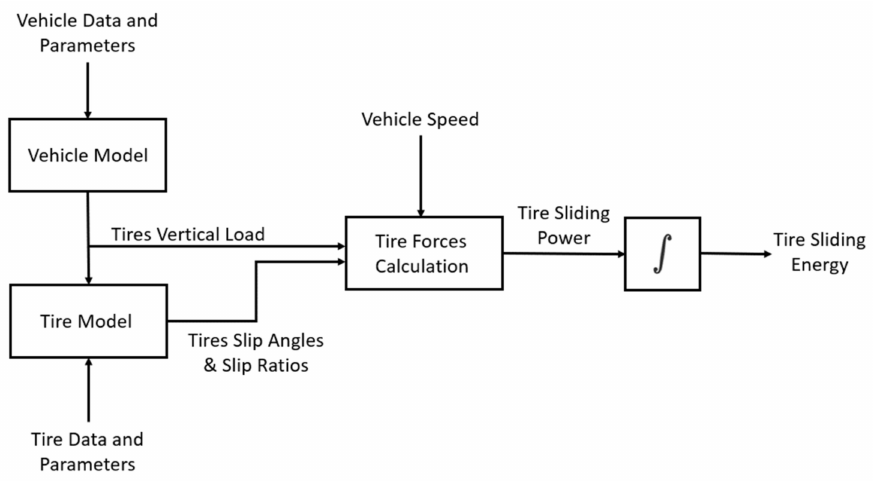
Figure 1. Modeling process